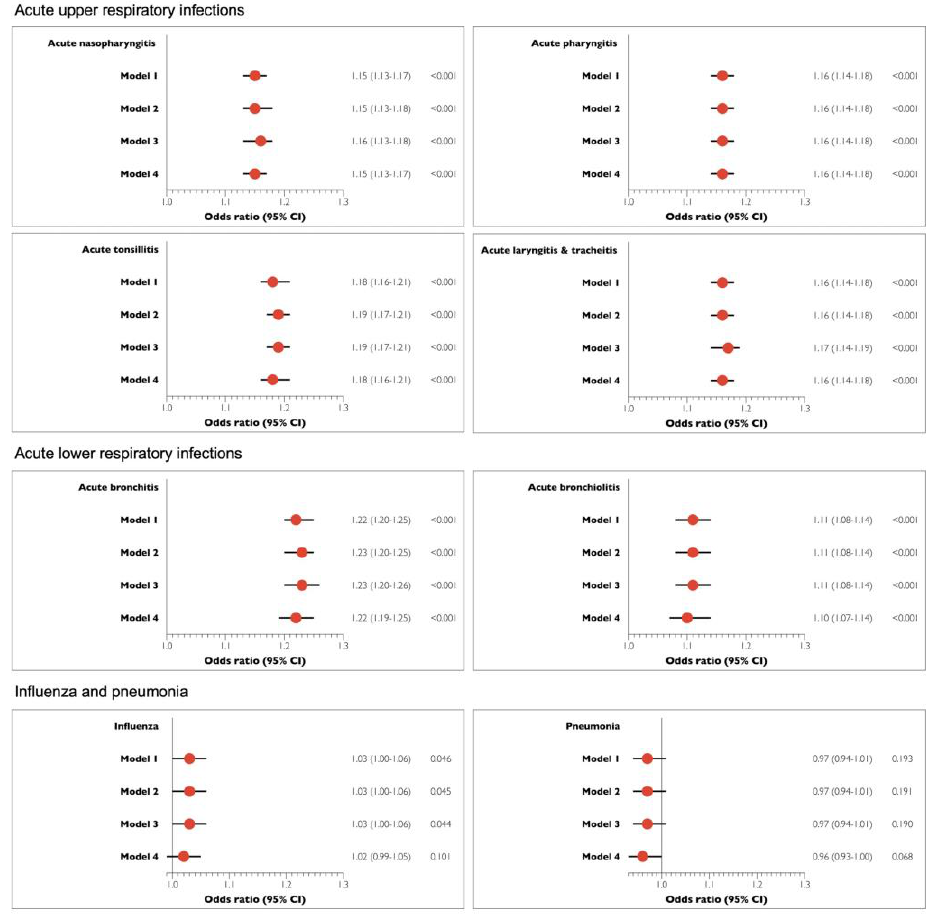
Figure 2. Associations of acute respiratory infections with chronic periodontitis in the univariate and multivariate logistic regression analysis. Model 1: unadjusted, Model 2: adjusted for age and sex, Model 3: model 2 plus adjustment for smoking and household income status, and Model 4: model 3 plus adjustment for diabetes mellitus.